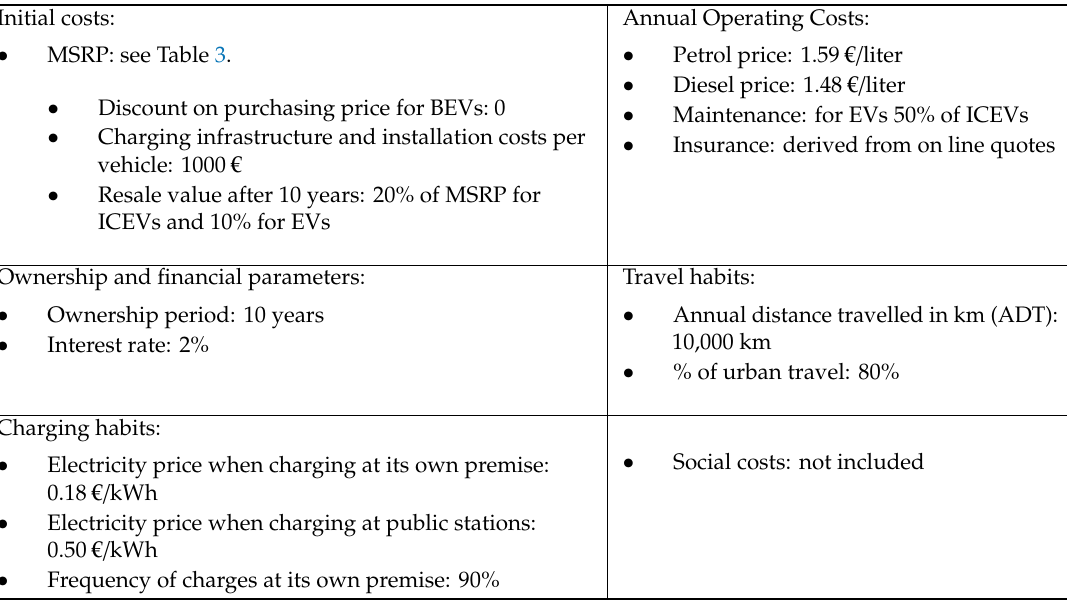
Table 3. Model parameter assumptions in the baseline